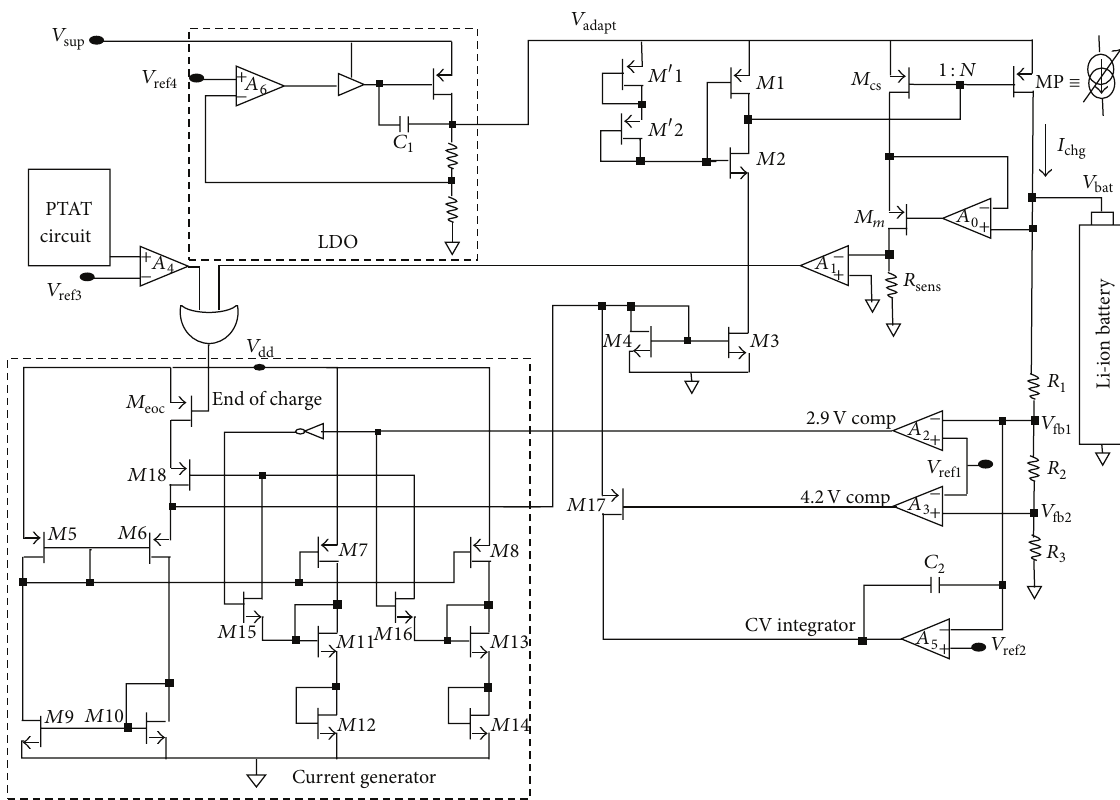
Figure 4: Complete architecture of the proposed Li-ion battery charger.